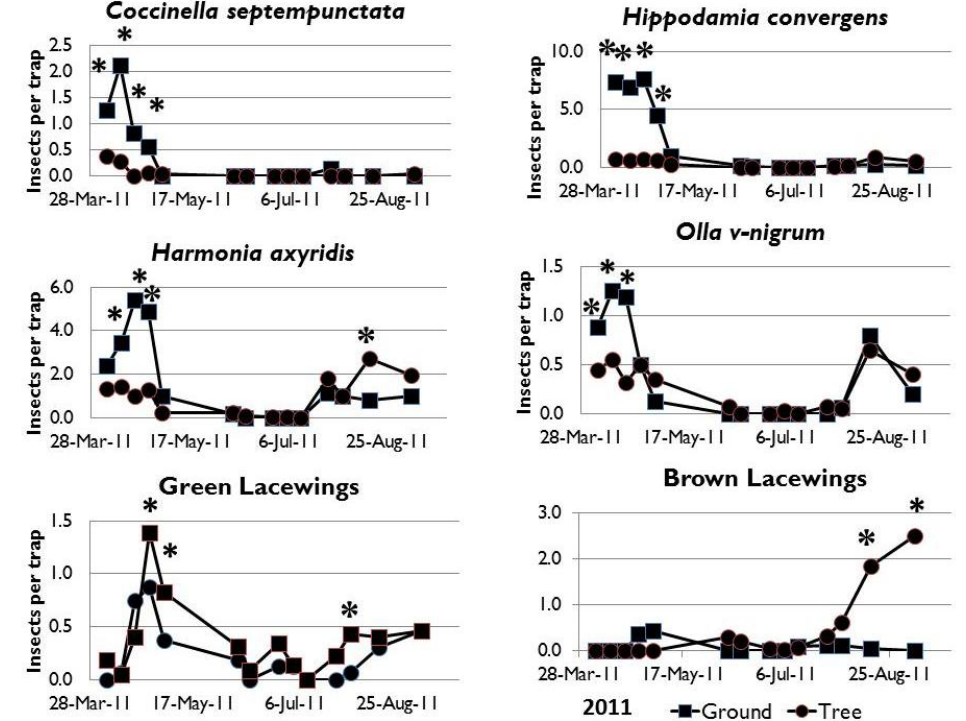
Figure 2. Comparison of sticky board trap catch of aphidophagous insects at the ground level (square marker) and in the pecan tree canopy (circle marker) in 2011. An asterisk above the data line indicates that on the indicated sample date the mean trap catch of the insect on the ground was significantly different from the mean trap catch in the tree canopy ( p < 0.05, one-way ANOVA, n = 16 traps per